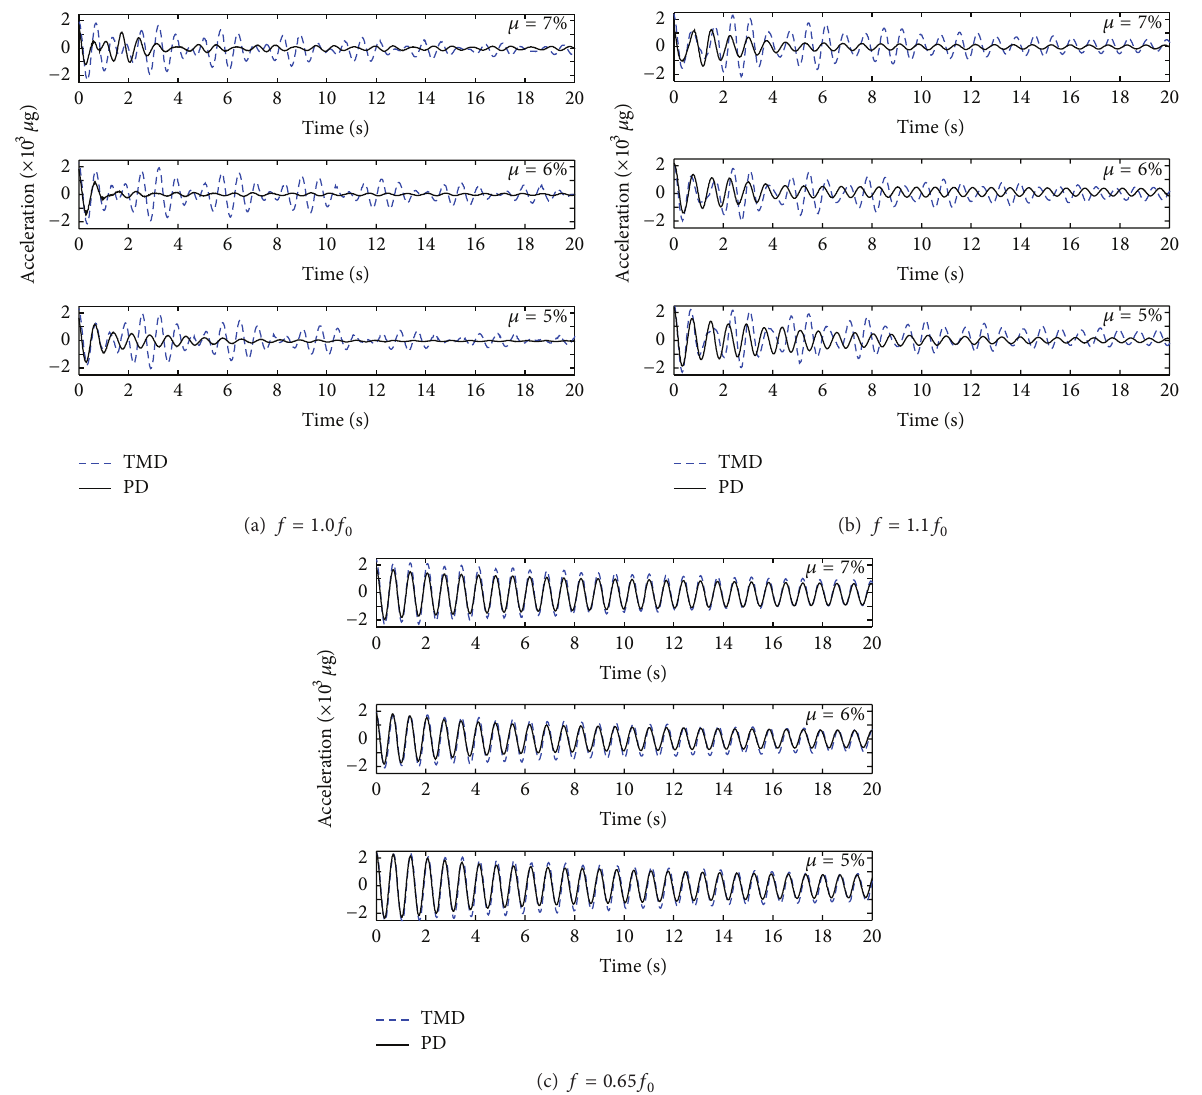
Figure 5: Acceleration time history of the primary